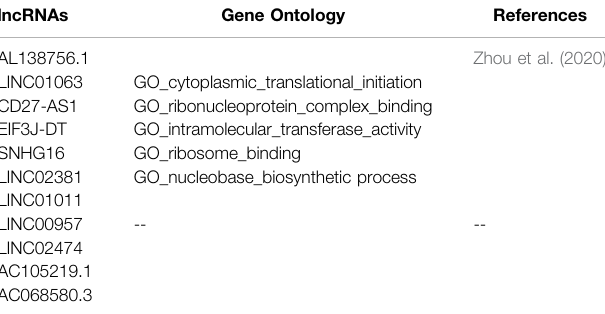
TABLE 3 | Summary of gene ontology involving eleven